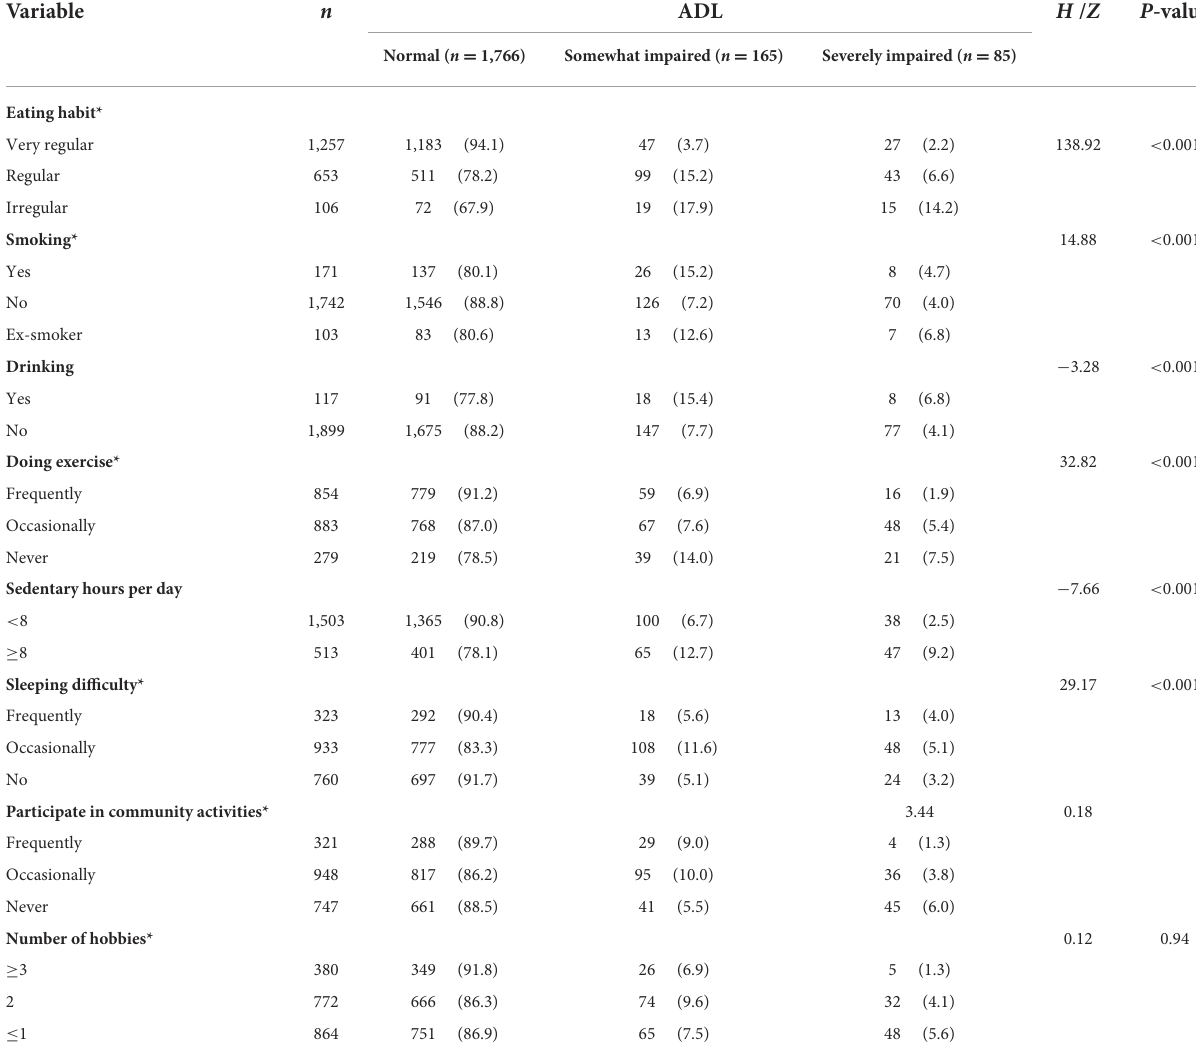
TABLE 3 Comparison of activities of daily living (ADL) functions by individual behaviors in older people with type 2 diabetes in Fuzhou.